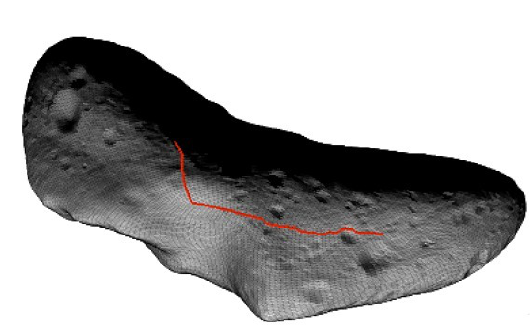
Figure 1. Optimal path of some generic rover on the surface of (433) Eros. The cost function involves illumination, surface roughness, and slope to equal weights. The light source (point) is located at the bottom left hand side corner, shading indicates illumination (see [4] for shape